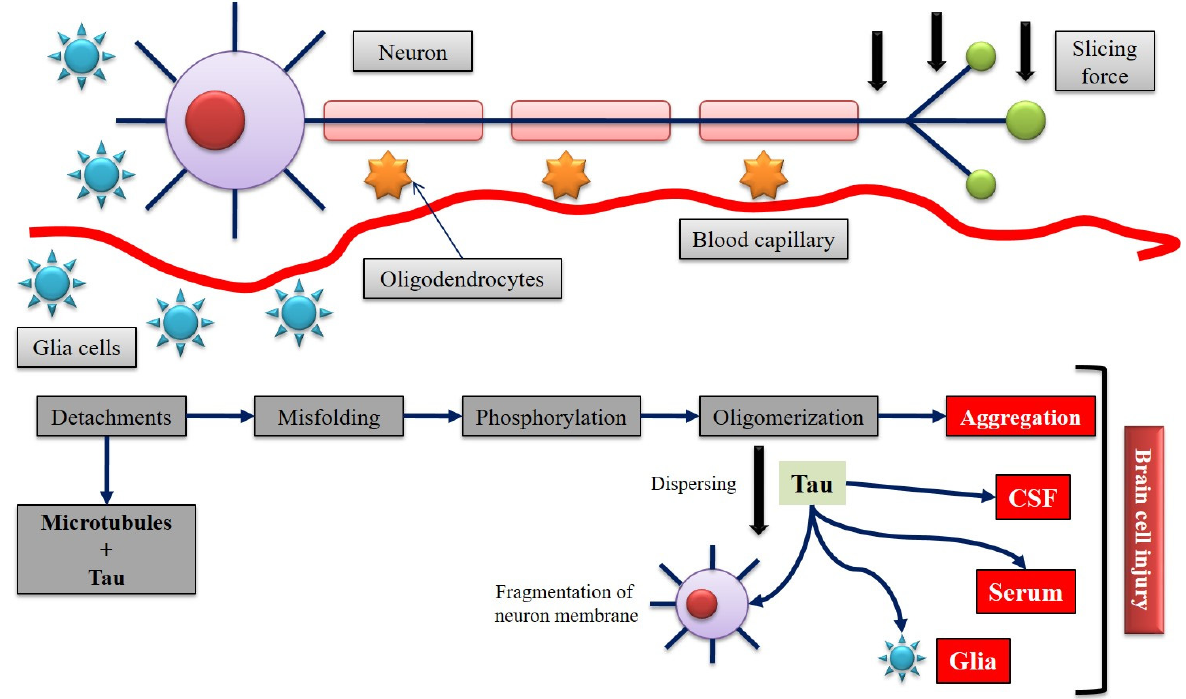
Figure 4. Expected molecular mechanism of brain injury on tau in the nervous system. Neurons, glia, oligodendrocytes, and blood vessels are damaged by the impact load that arises after a head injury. Injury to some or more of these cells causes intracellular unfolding, which causes the entire device to malfunction. Tau, which is highly correlated with microtubules, is abundant in axons. Impact forces devastate cell membrane integrity, as well as the microtubule framework in the axon. Tau disengages from the microtubule as it becomes unstable. Tau would then be misfolded, phos- phorylated, develop a porous oligomeric conformation, accumulate, or disperse in a dysfunctional pathway. Tau may also invade other neighboring cells (glia, serum, or CSF) as it spreads. Due to the extreme sudden TBI-induced protein abundance, protein catabolic path- ways such as autophagy and proteasomal degradation may become exhausted